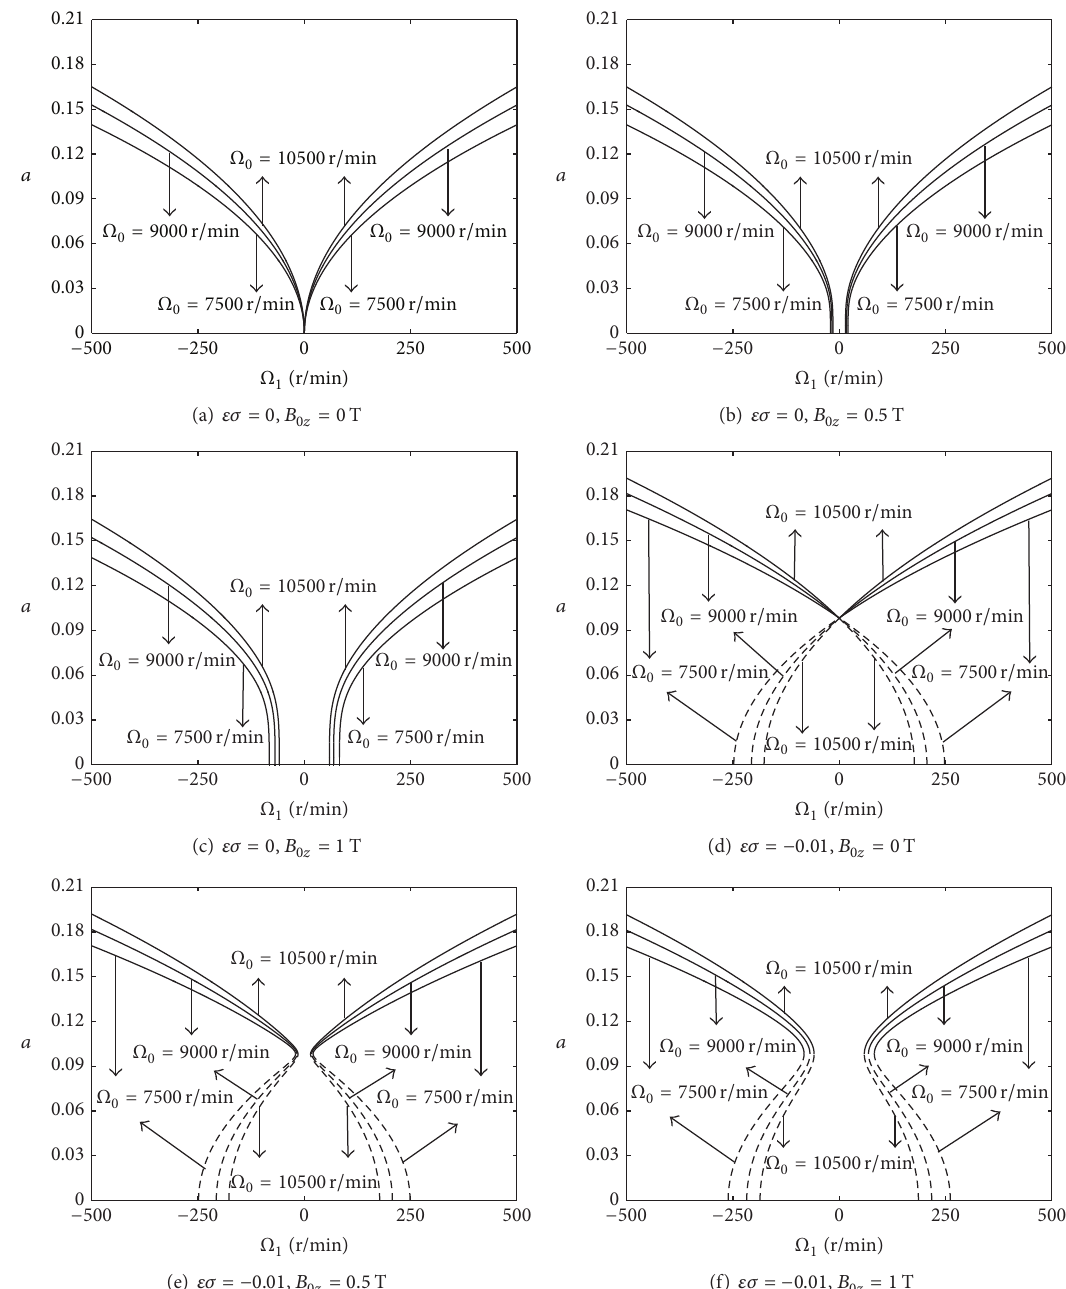
Figure 6: The characteristic curves of resonance amplitude-amplitude of velocity disturbance term.